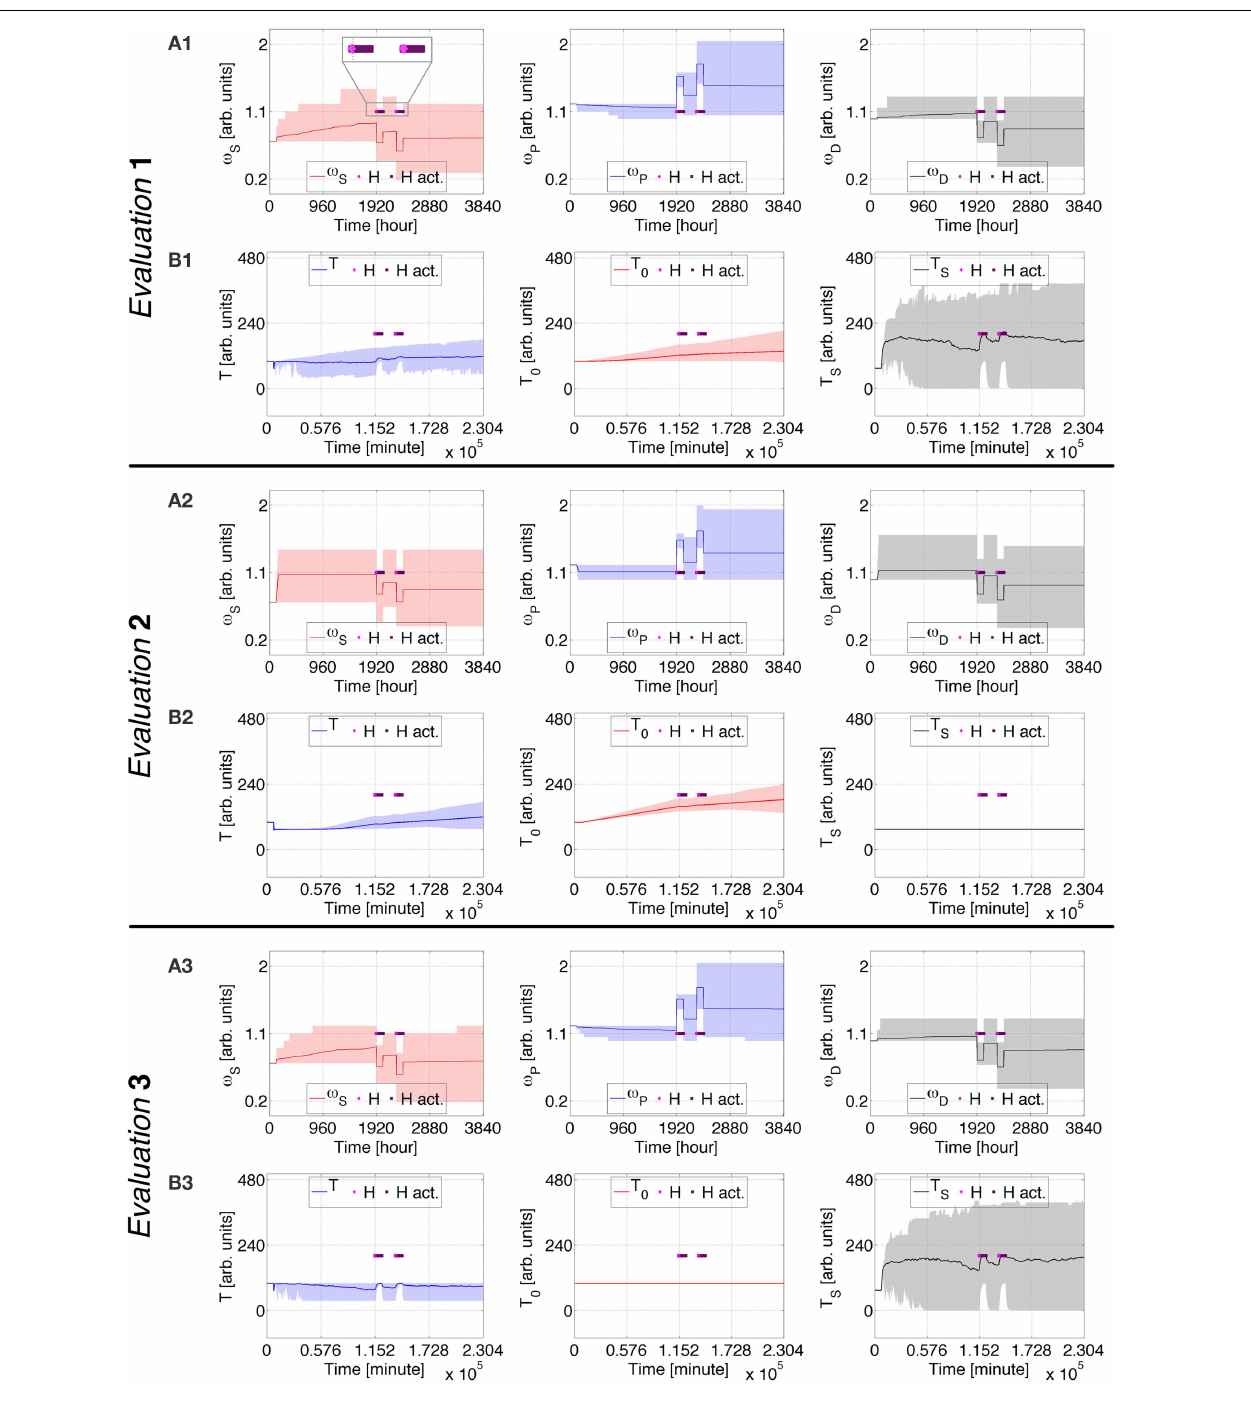
recovery process H is activated at t = 1920 and t = 2280 [hours] (in light pink) and stays active for 120h (dark pink). (A1–A3) show the evolution of cognitive weights ω S , ω P , and ω D ; and (B1–B3) the progression of T , T 0 , and T S .The shades correspond to 95% simulation envelopes.The time-scales are hours for (A1–A3) , minutes for (B1–B3) . Further details of these simulations are reported in FiguresS7 and S8 in Supplementary